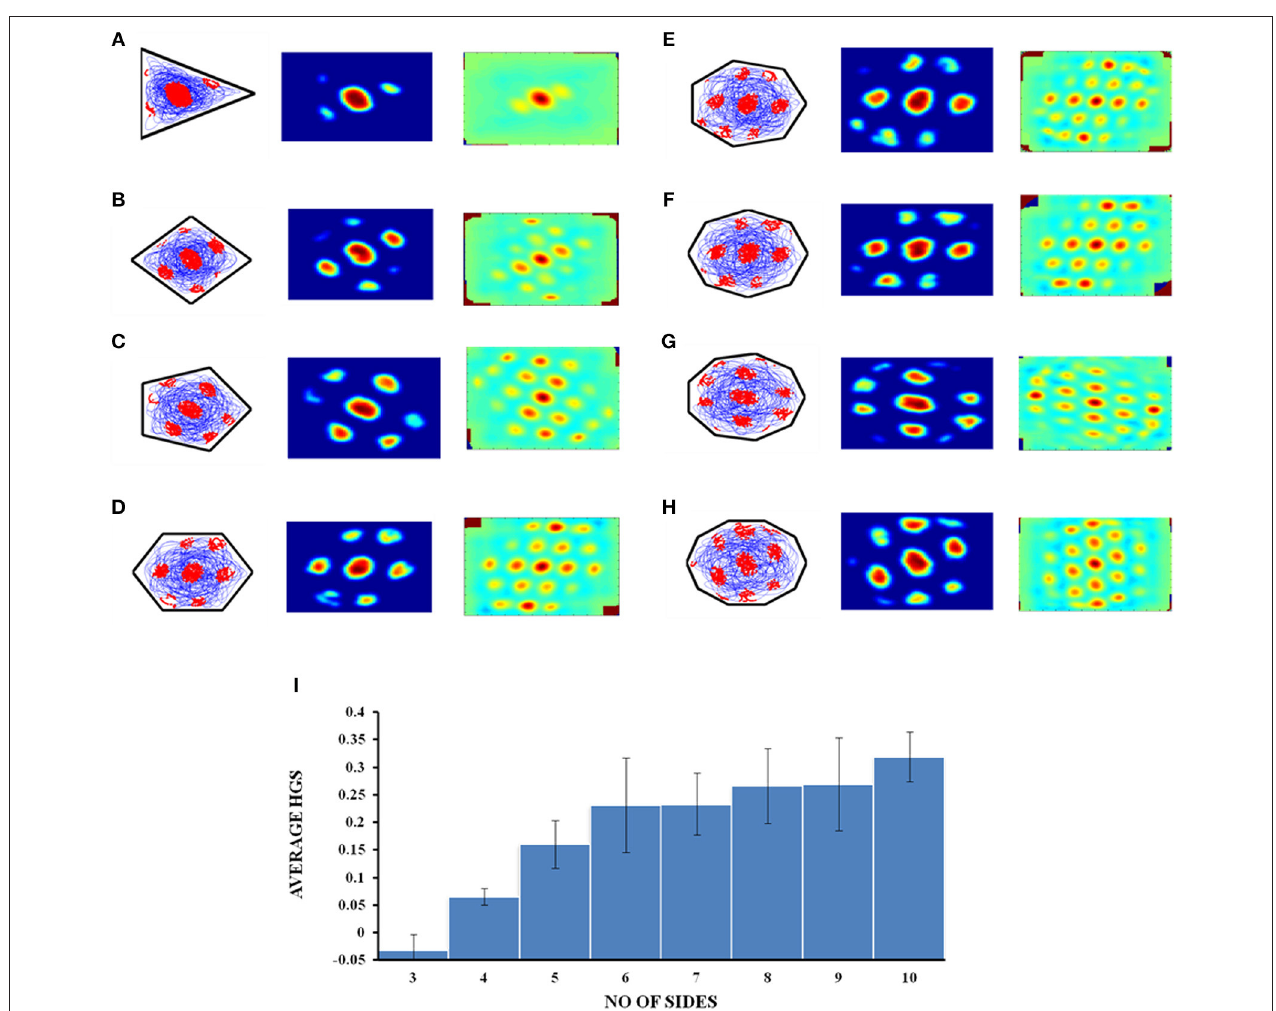
FIGURE 10 | Grid cell firing in regular polygons. (A–H) Firing field, firing rate map and autocorrelogram (from left to right) of triangle, square, pentagon, hexagon, heptagon, octagon, nonagon, and decagon shapes, respectively. (I) The average HGS value of the grid field obtained for each polygon vs. the number of sides of the polygon. The plot shows an increasing trend as the polarity of the environment